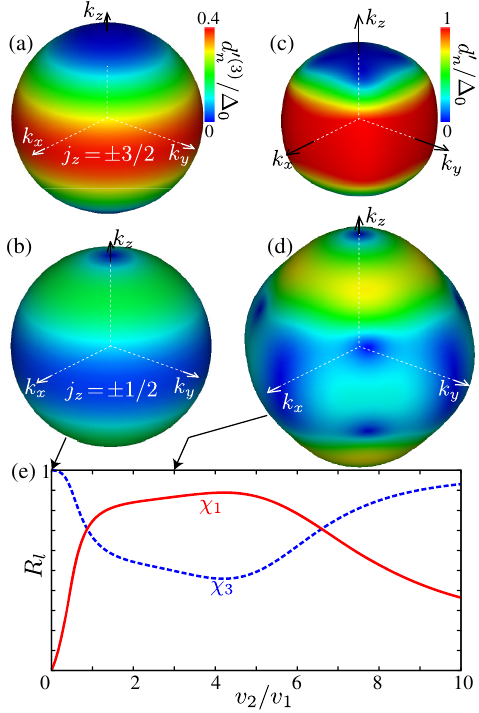
FIG. 12. Energy gap d 0 of T 1 representation on the Fermi n u surfaces for v 2 ¼ 0 (a),(b) and 3 v 1 (c),(d). (a),(c) and (b),(d) show the inner and outer Fermi surfaces, respectively. (e) Mixing ratio of angular momenta l ¼ 1 and l ¼ 3 pairs for T 1 gap function ffiffiffi u p ˜ J 2 = 5 ⊗ σ Δ ¼ Δ . The parameters are the same Þð χ 1 J z þ χ 3 0 ð z Þ y as in Fig.